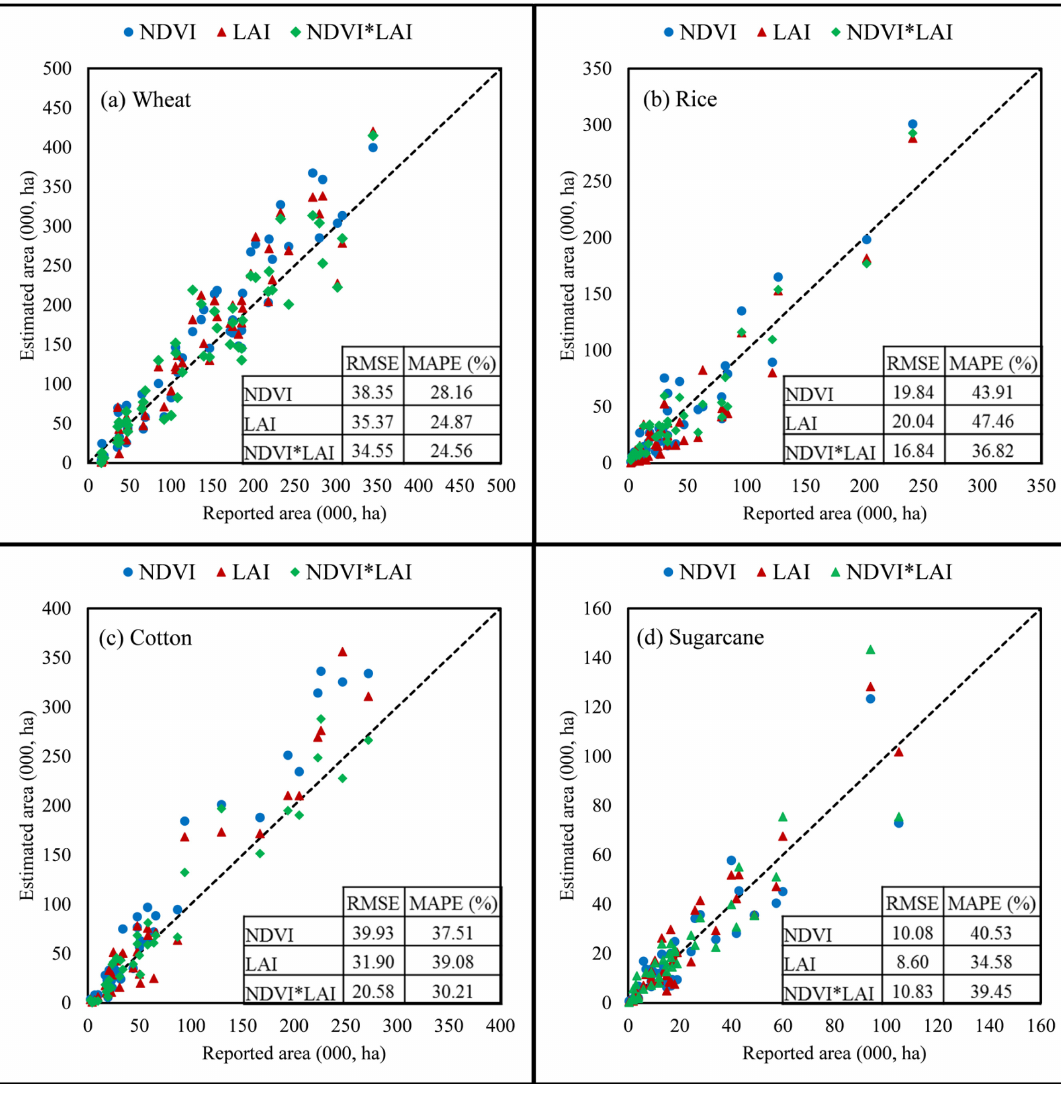
Figure 4. Comparison of estimated crop area with reported area of (a) wheat, (b) rice, (c) cotton and (d) sugarcane.